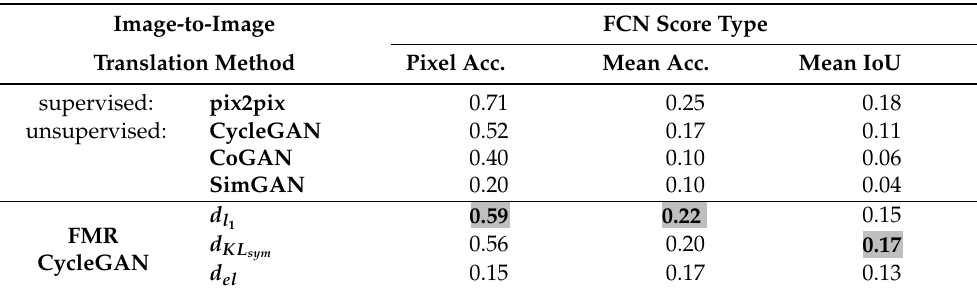
Table 3. FCN scores of the proposed FMR CycleGAN against the baseline unsupervised and super- vised methods, for different ground distances utilized in feature map regularization. The results correspond to semantic photo2label domain translation task performed on the CityScapes dataset (the best unsupervised results are highlighted in bold and